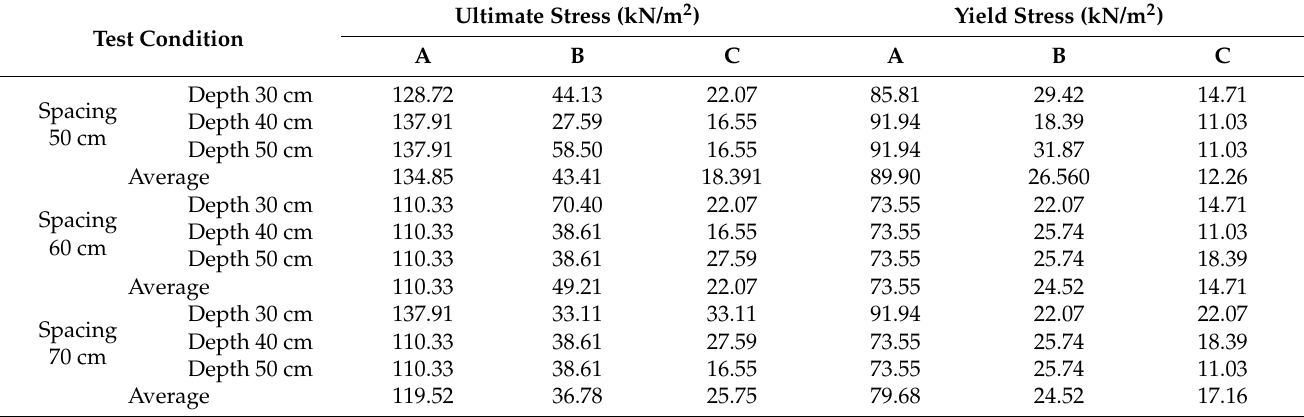
Table 5. Ultimate and yield stresses of embedded depth and rafter spacing on site A, site B, and site